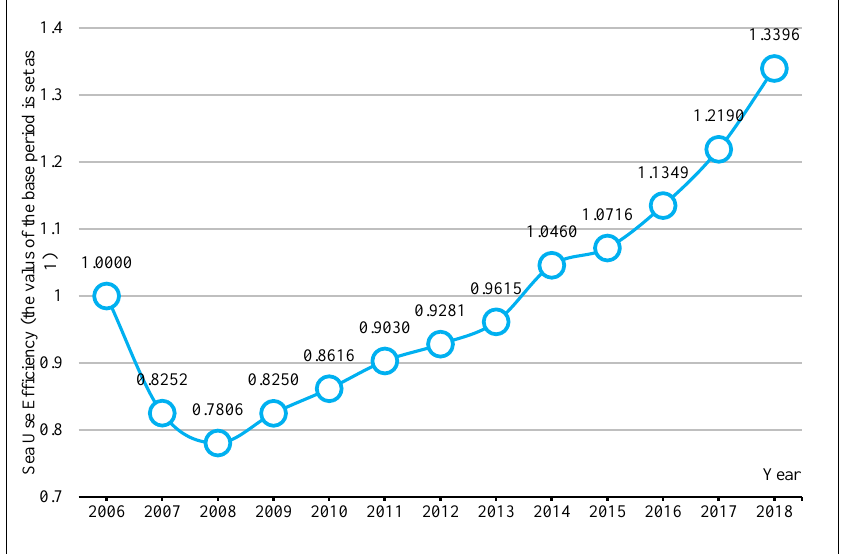
Figure 3. Changing trends of SUE in China, 2006 – 2018.